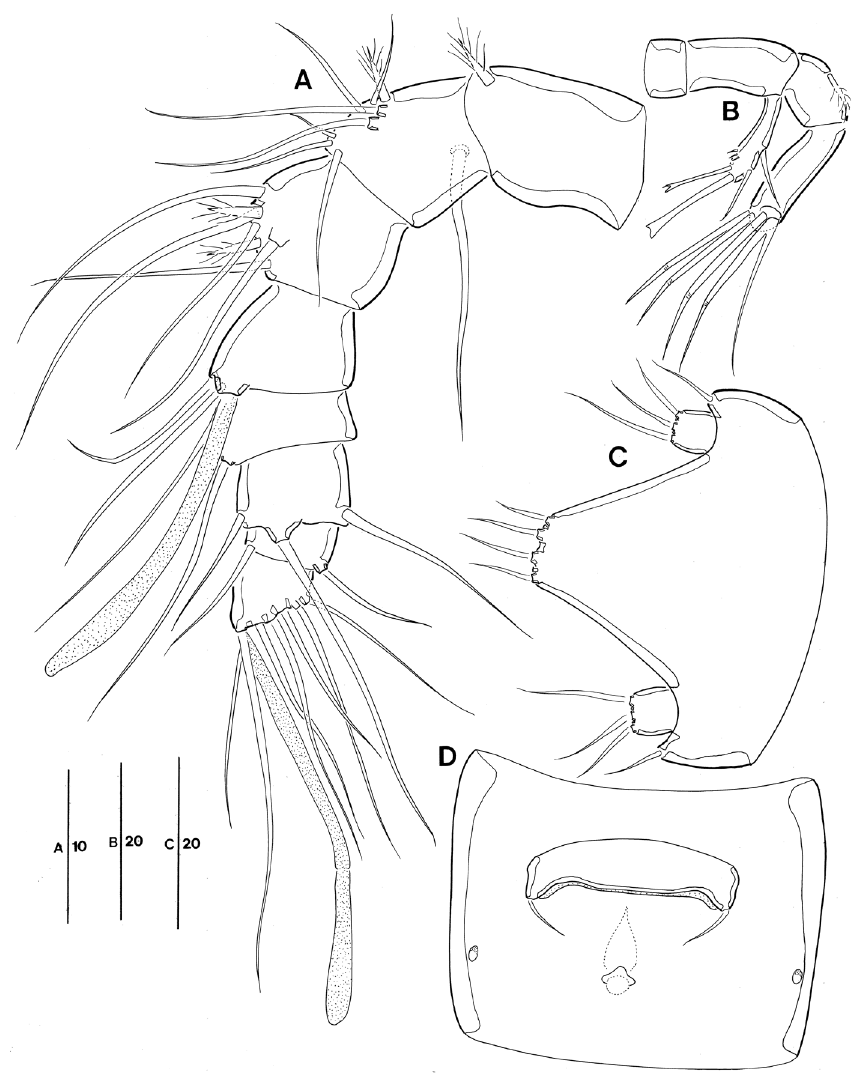
Figure 2. Leptopsyllus ( Leptopsyllus ) pundius sp. n. ( ♀ ). A antennule B antenna C P5 D P6 and genital field. Scale bars are in